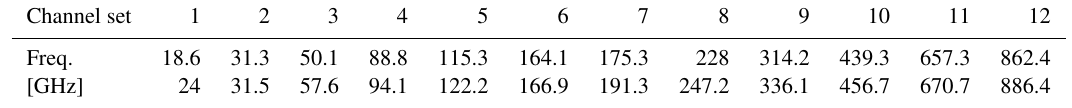
Table 2. The frequencies of the scattering calculations. Except for 35 . 6GHz, the channels ≥ 18 . 6GHz are organized in channel sets; see text. Channel set